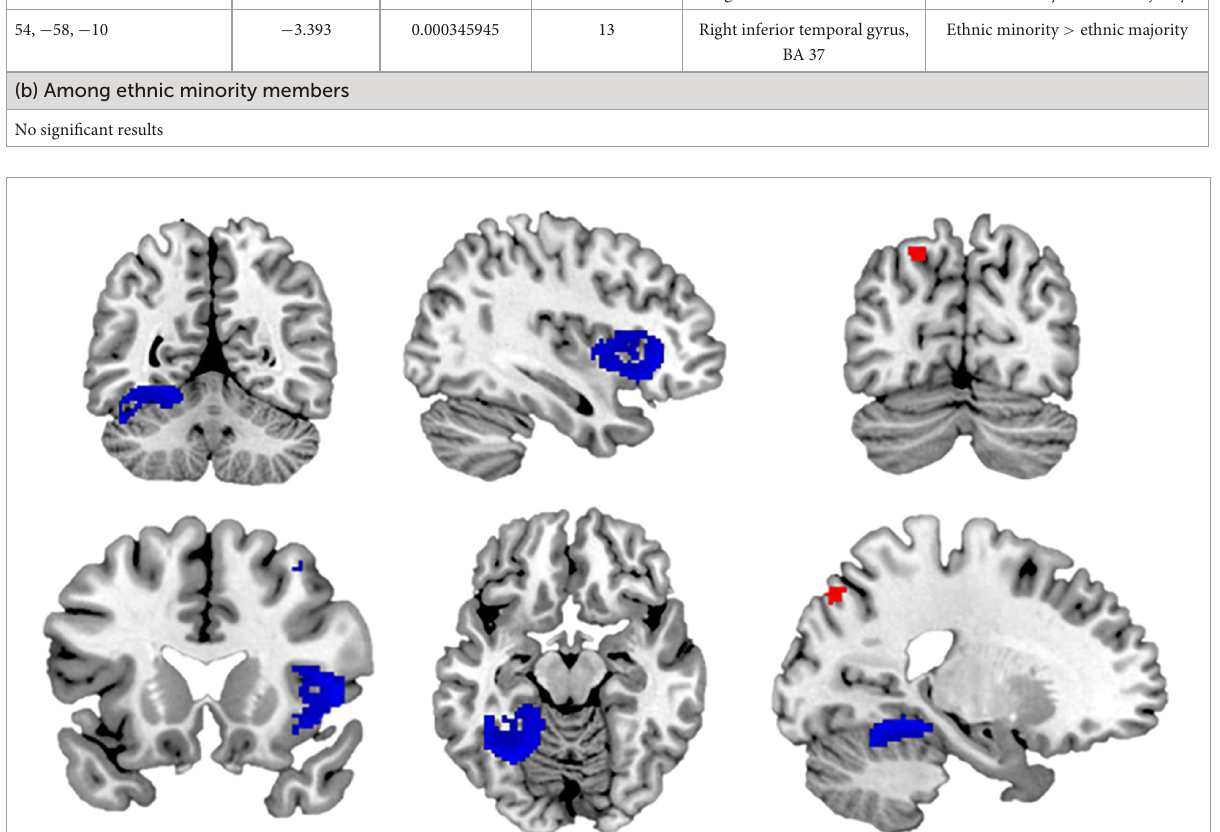
FIGURE2 The results of the meta-analysis among ethnic majority members. The brain regions with higher activity toward ethnic majority (vs. minority) members are marked with red color; and the brain regions with higher activity toward ethnic minority (vs. majority) members are marked with blue